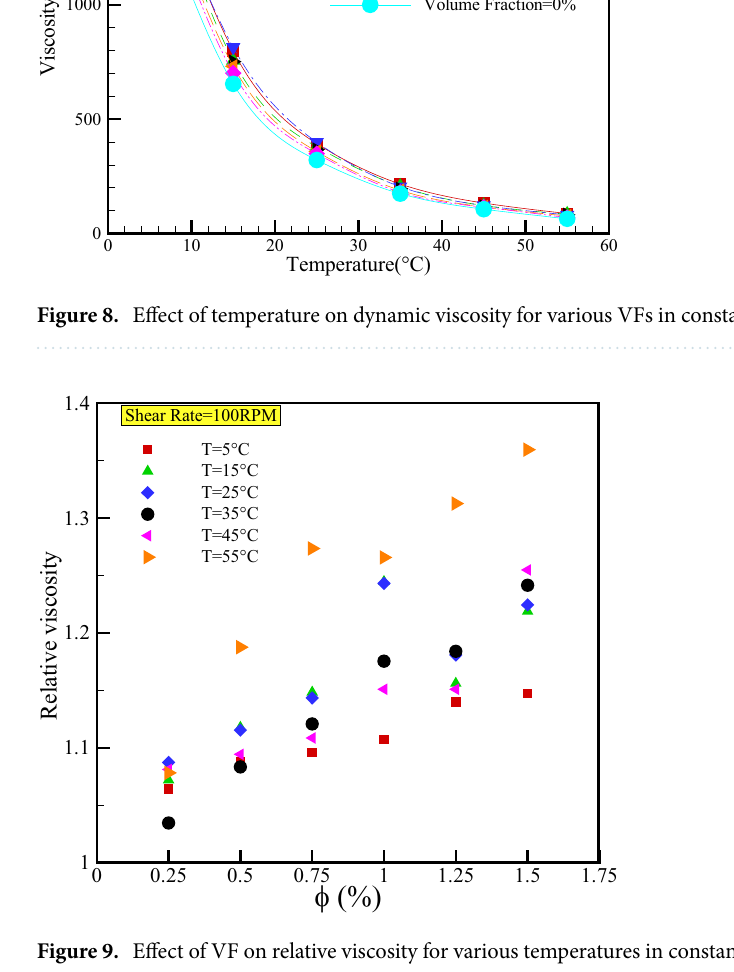
Figure 9. Effect of VF on relative viscosity for various temperatures in constant SR of 100